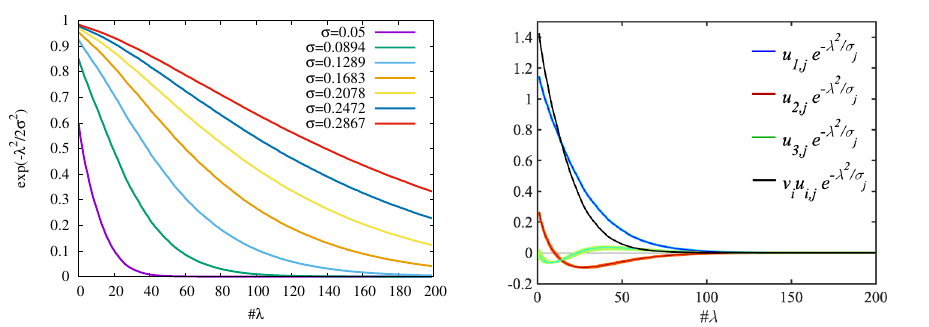
Figure 3. The Gaussian profiles (left) pruned by SVD vectors to ’optimal’ profiles (right) for the GEVP.